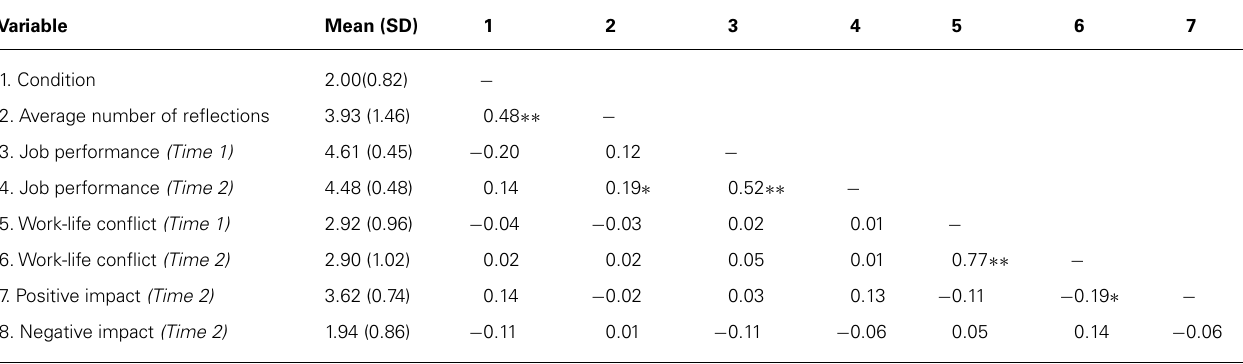
Table 1 | Means, SD, and bivariate correlations for all variables. Variable